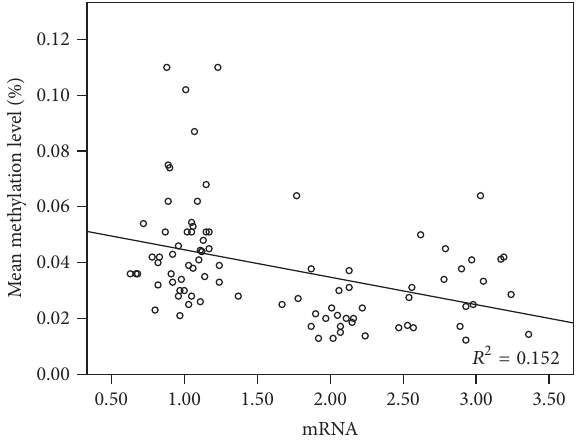
Figure 6: Analysis of the correlation between methylation level and mRNA expression of FOSL2 . The methylation level was set as the 𝑦 -axis and mRNA as the 𝑥 -axis in regression